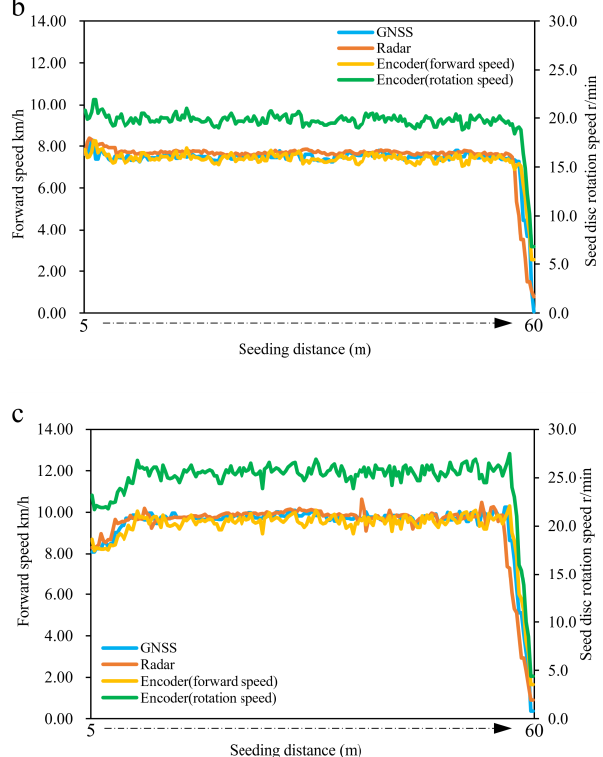
Figure 13. The speed monitoring value of three uniform-speed seeding tests (a, b, and c: three uni- form-speed seeding tests).